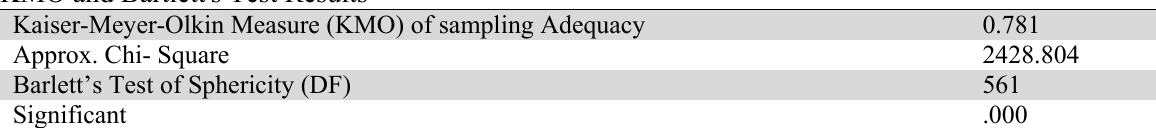
KMO and Bartlett's Test